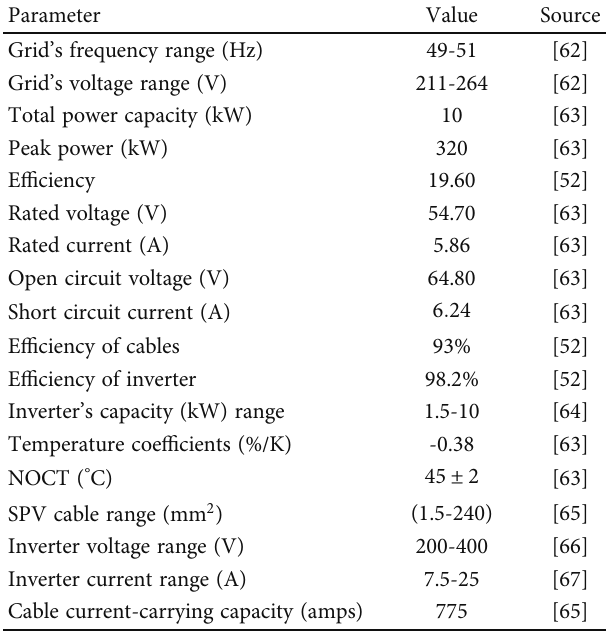
Table 1: Speci fi cations of the SPV (monocrystalline)